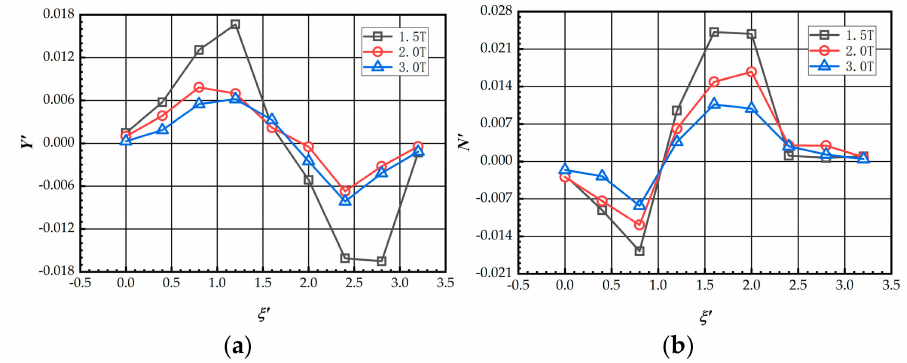
Figure 16. ( a ) The lateral force of DS at different depth; ( b ) The yaw moment of DS at different depth. The patterns shown in Figure 16 are consistent with the changes in pressure distribu- tion on the hull shown in Figure 17. In the case of ξ (cid:48) = 0.8, a decrease in depth leads to the decrease in pressure in the negative-pressure zone at the stern of DS and results in an increase in the sway force. Since there is little change in the pressure in the front of the hull as the water depth decreases, such a decrease in the pressure at the stern results in greater yaw moments.